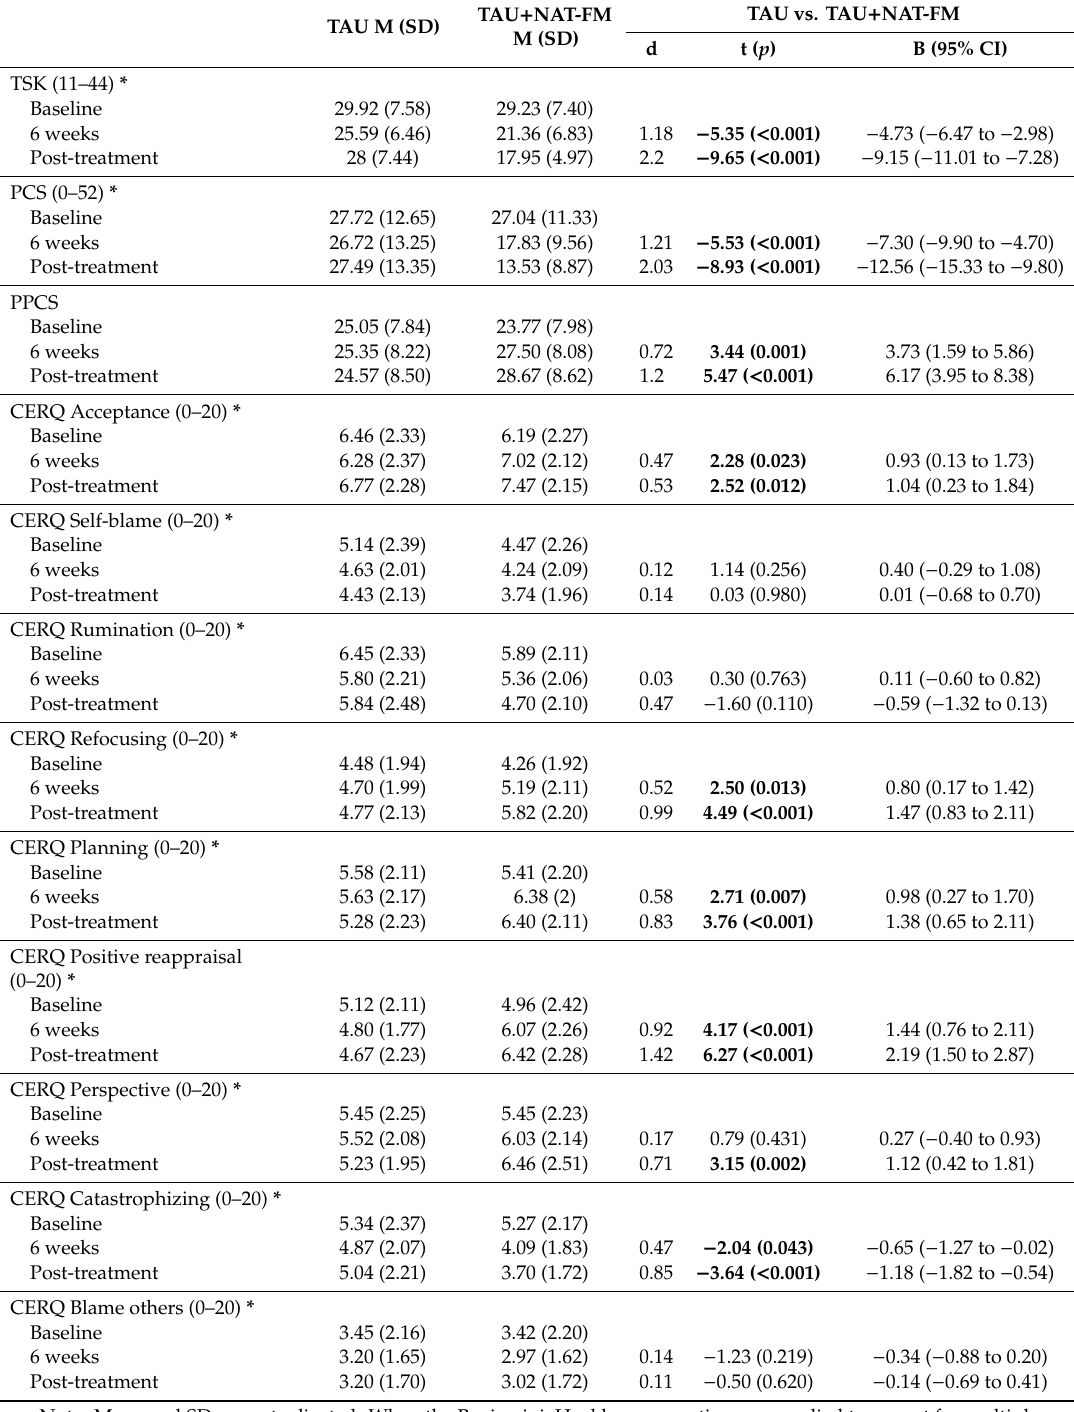
Table 5. Descriptive statistics and between-group analyses for process variables (ITT